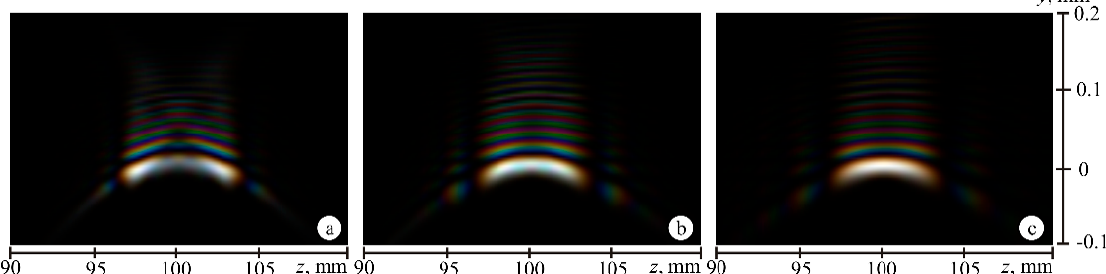
Figure 11. PSF longitudinal distribution patterns with a CoC size limit of 0.02 mm ( z ∈ [90 mm; 110 mm], y ∈ [ − 0.1 mm; 0.2 mm]) for n = 3, α = 0.00045 ( a ); n = 4, α = 0.00054 ( b ); and n = 5, α = 0.00081 ( c) at three wavelengths of the illuminating beam: λ = 460 nm (blue), 550 nm (green), 640 nm (red).